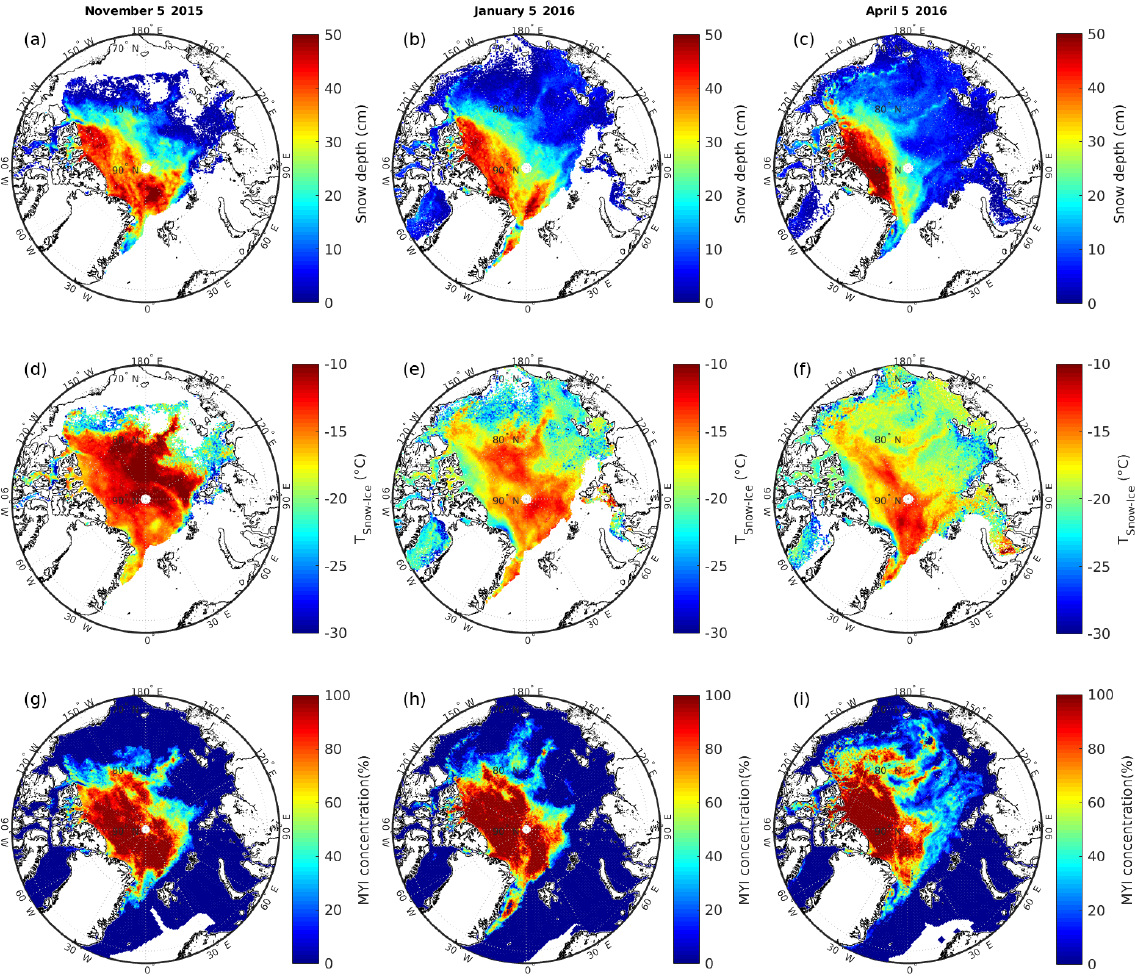
Figure 12. Maps of the snow depth (a, b, c) and the T Snow − Ice (d, e, f) estimated from our multilinear regression using AMSR2 TBs, with multi-year ice (MYI) concentration products (g, h, i) from the University of Bremen on 5 November 2015 (a, d, g) , 5 January 2016 (b, e, h) , and 5 April 2016 (c, f, i)